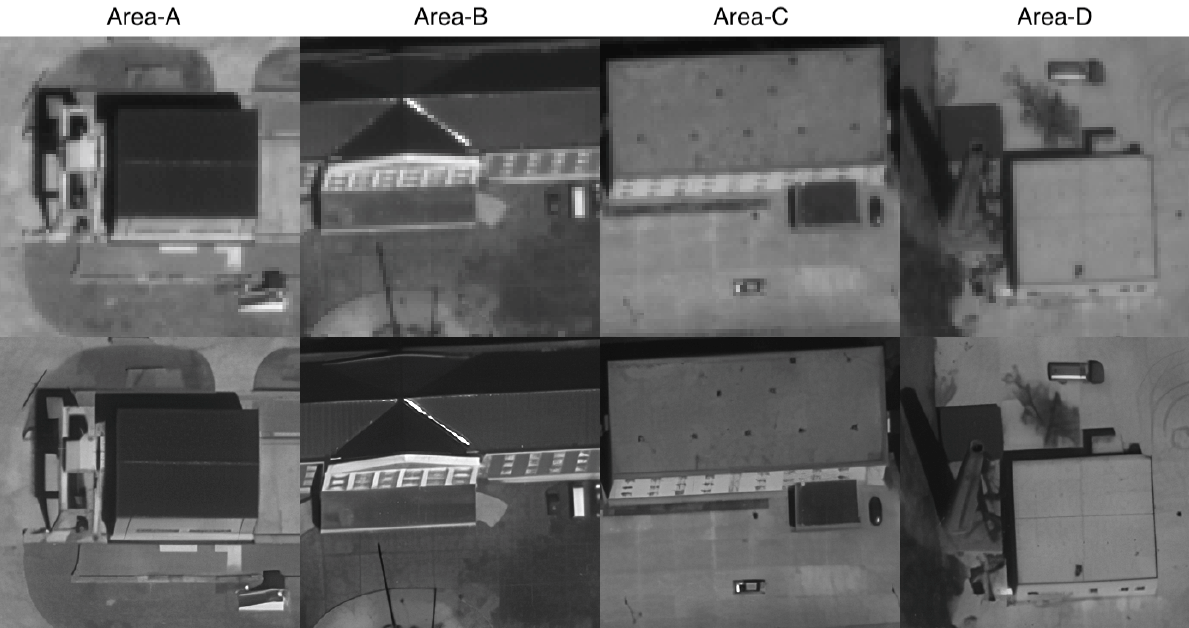
Figure 13. Examples of the 31 cm/pixel WorldView-3 image (20MAY16150148-P2AS-012860253010_01_P002) crops and the corresponding OpTiGAN SRR results showing snow surface features over a Greenland site. All sub-figures have a size of 27 m by 27 m. WorldView-3 image courtesy of Maxar 2020. Data provided by the European Space Agency.